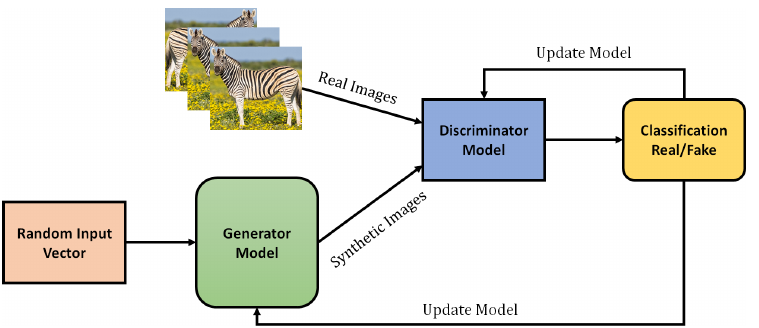
Figure 10. A general architecture of the Generative Adversarial Networks